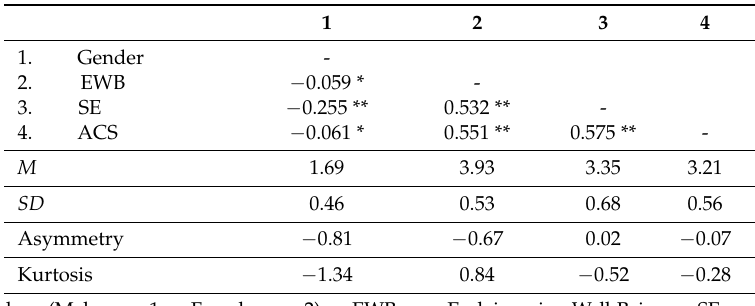
Table 1. Descriptive statistics and Pearson correlation